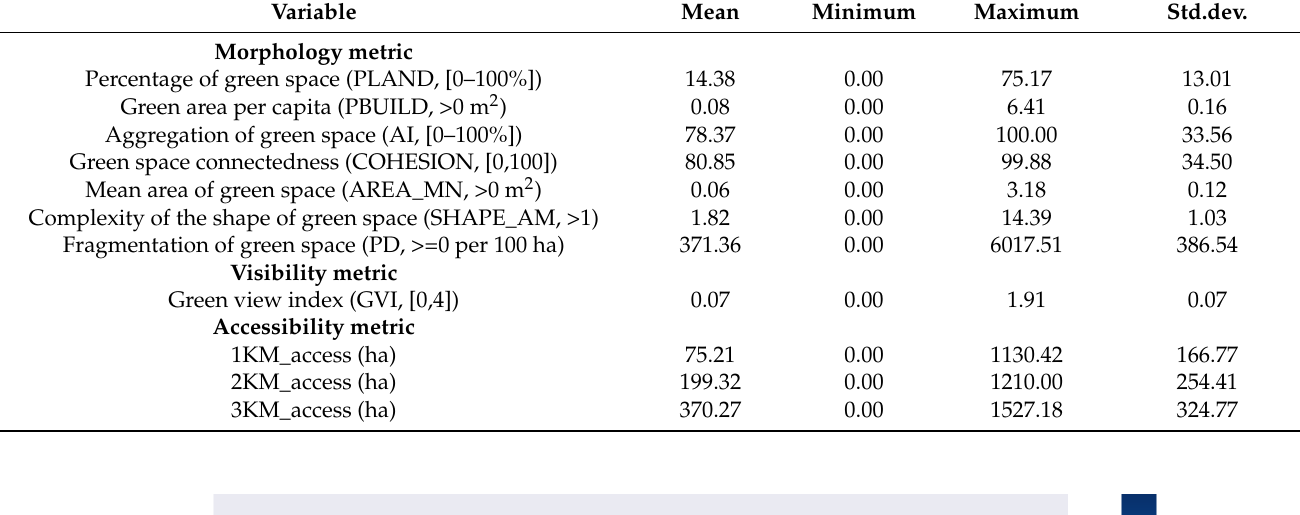
Table 2. Descriptive statistics of green equity metrics in 4544 communities in Beijing urban area. Variable Mean Minimum Maximum Std.dev. Morphology metric